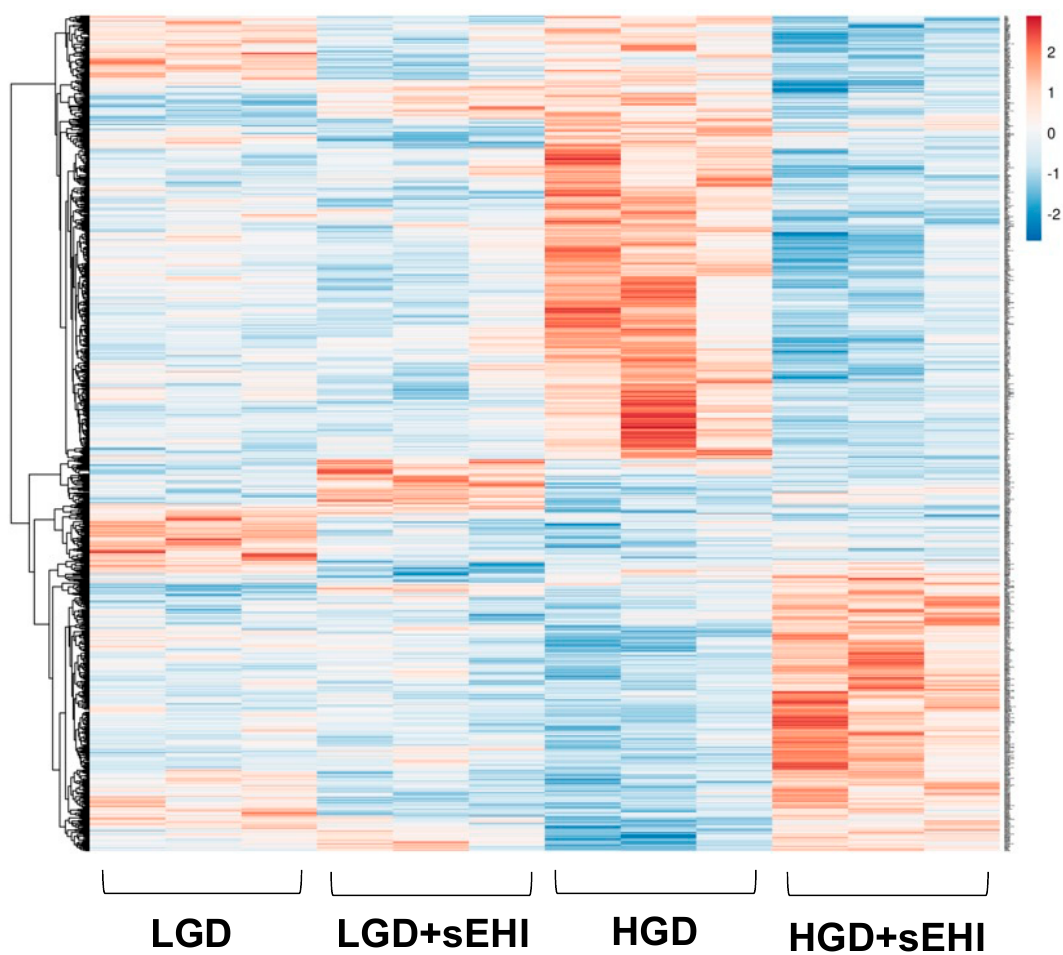
Figure 5. Hierarchical clustering of differentially expressed genes in hippocampal microvessels for the low glycemic diet (LGD) and the high glycemic diet (HGD) with and without soluble epoxide hydrolase inhibitor (sEHI). Hierarchical clustering of differentially expressed gene profiles in hippocampal microvessels of four experimental treatment groups: low glycemic diet (LGD), LGD with soluble epoxide hydrolase inhibitor (LGD+sEHI), high glycemic diet (HGD), and HGD with sEHI (HGD+sEHI). The data are shown for three biological replicates for each dietary group. Up-regulated genes are in red, and down-regulated genes are in blue. In the presence or absence of inhibitor, LGD groups had similar gene expression profiles while HGD groups had opposite gene expression